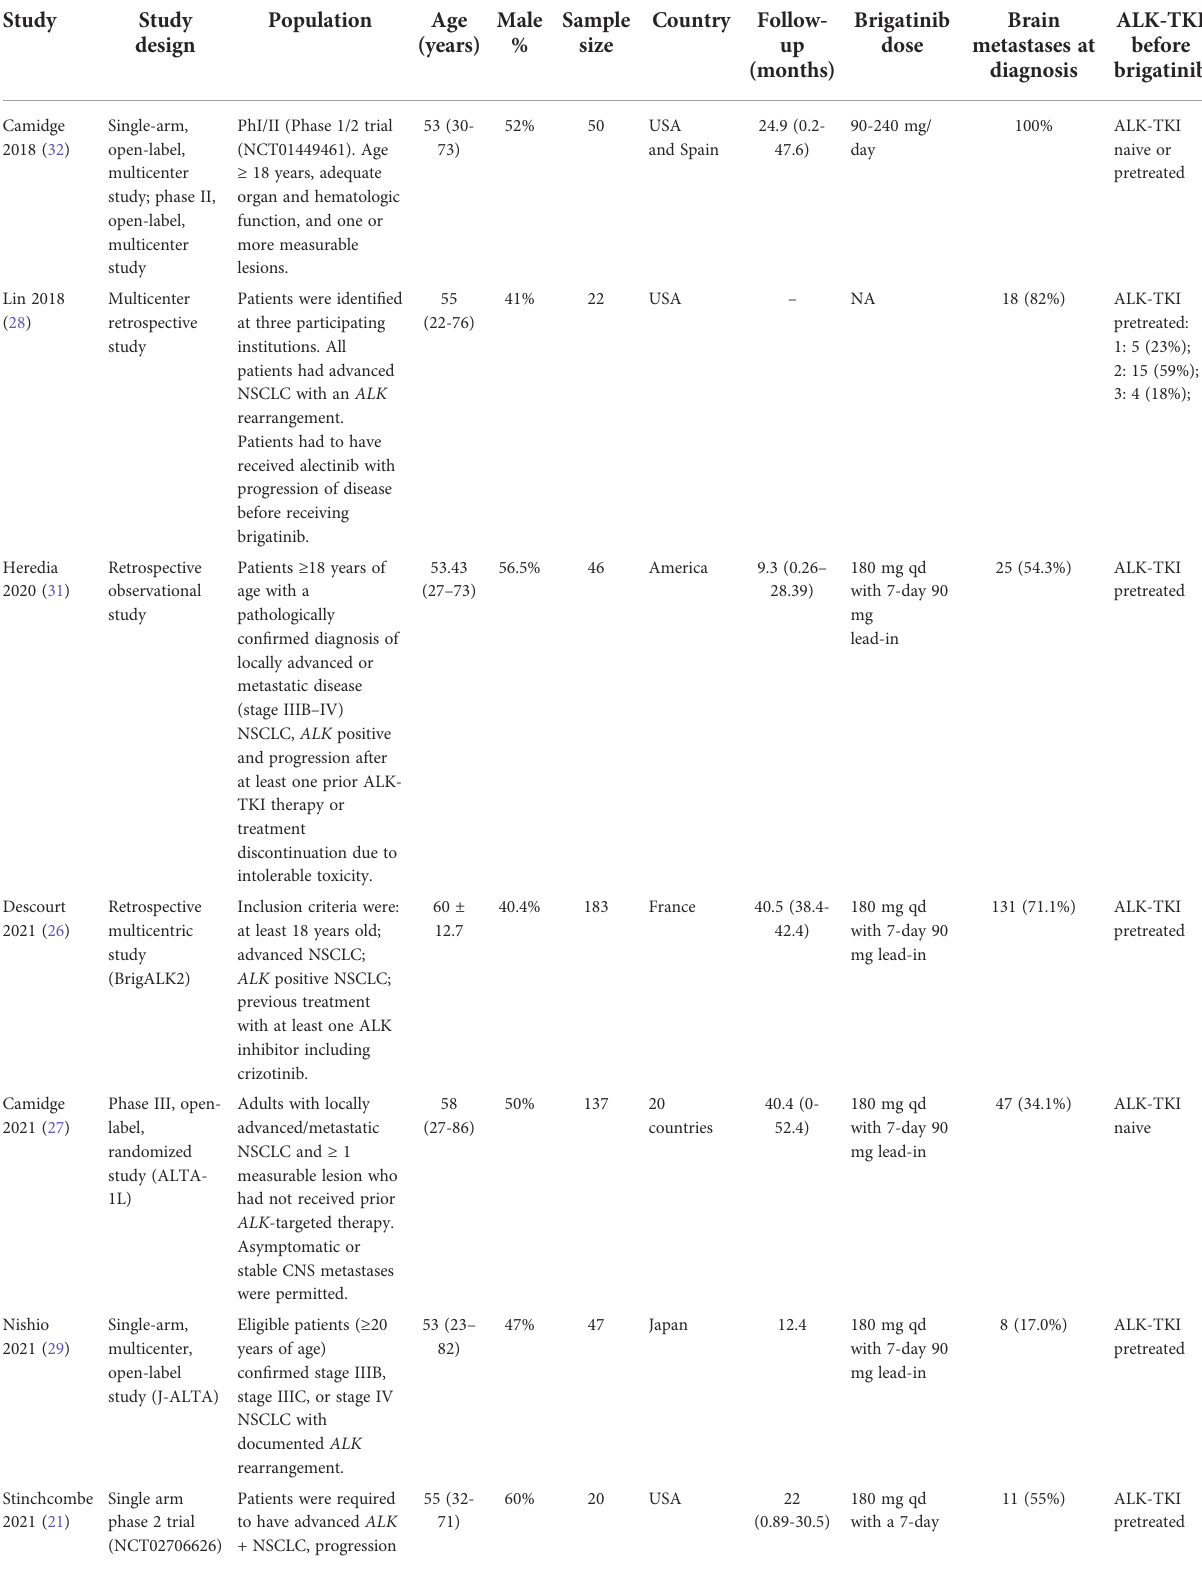
TABLE 1 Characteristics of the 10 included